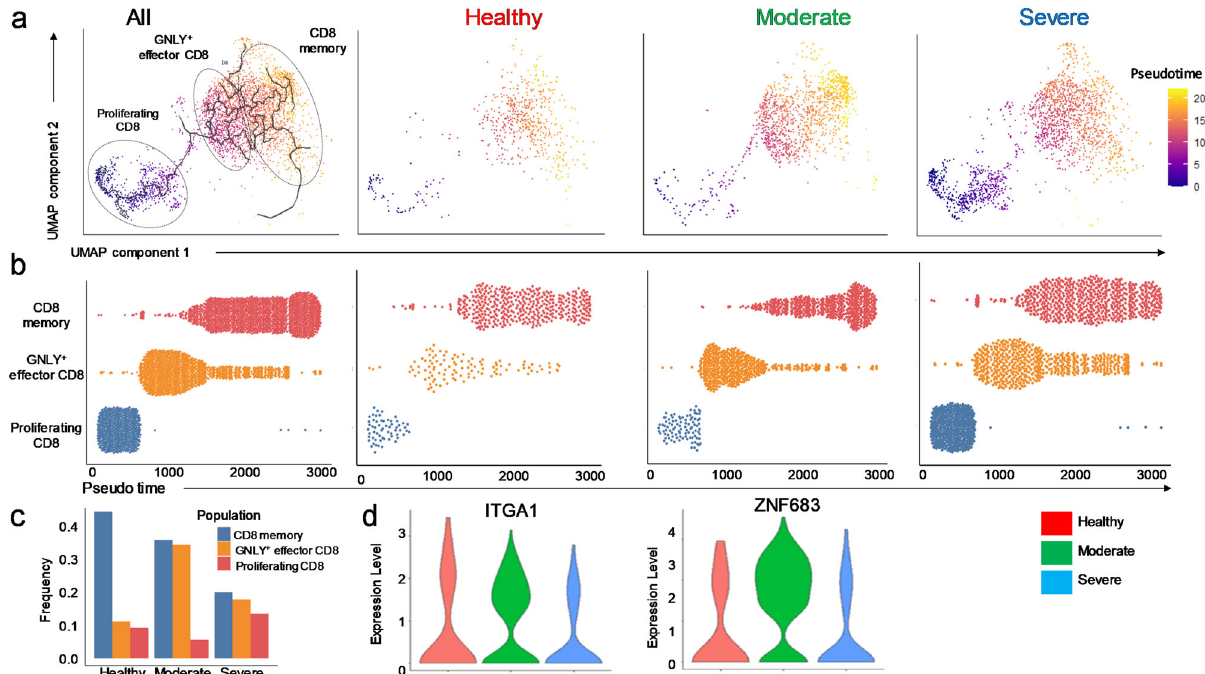
Fig. 4 Impaired memory differentiation of CD8 + Tc in COVID-19. Pseudotime and trajectory inference analysis to evaluate the kinetic differentiation of CD8 + Tc in the BALF during SARS-CoV-2 infection. a , b UMAP projection ( a ) and dot plot showing pseudotime values ( b ) of 3694 CD8 + Tc of reintegrated, healthy, moderate, or severe COVID-19 patients. c Bar graphs displaying the frequency of CD8 + Tc subpopulations across disease conditions; d Violin plot demonstrating the expression of tissue-resident memory encoding genes in CD8 + T M